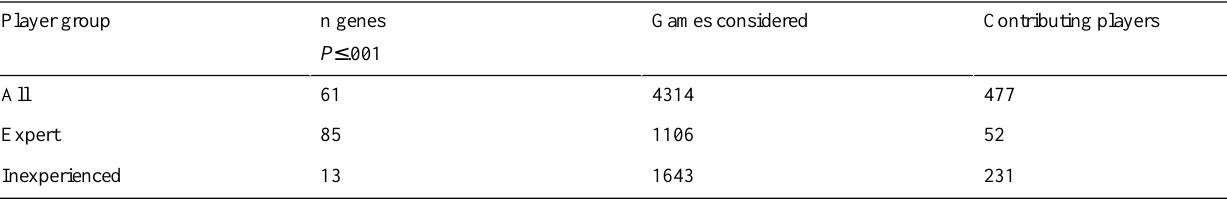
Table 1. Predictor gene sets derived from The